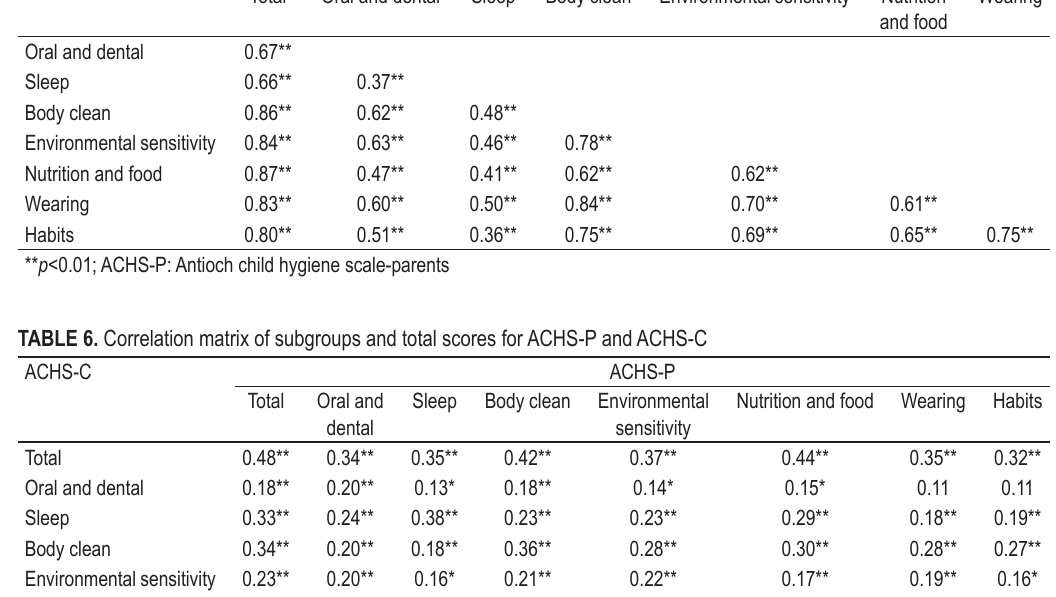
Wearing and food